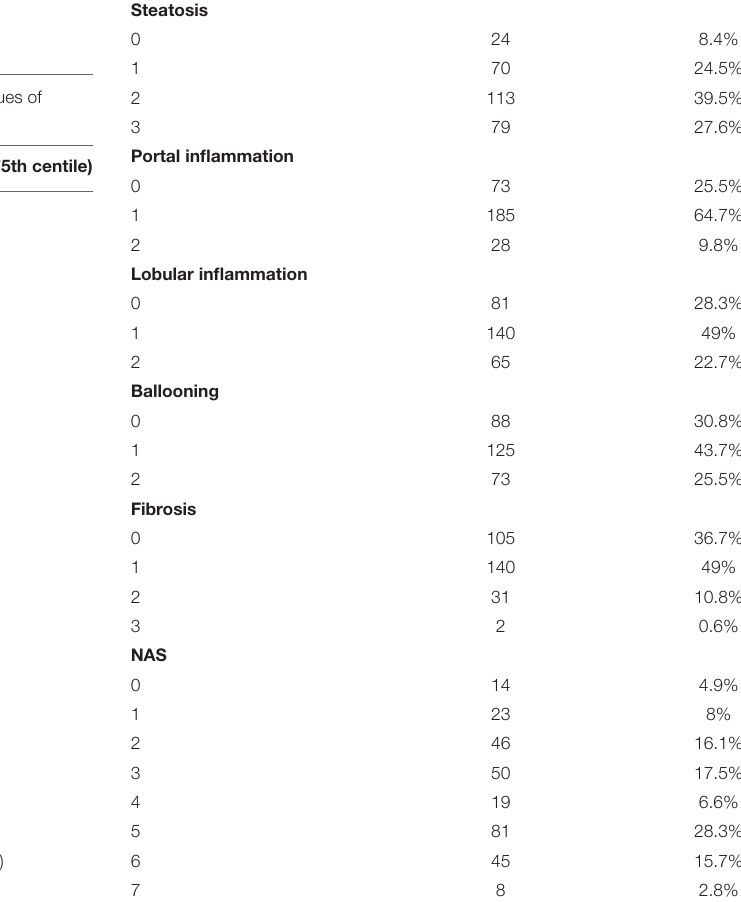
TABLE 2 | Histological characteristics of the